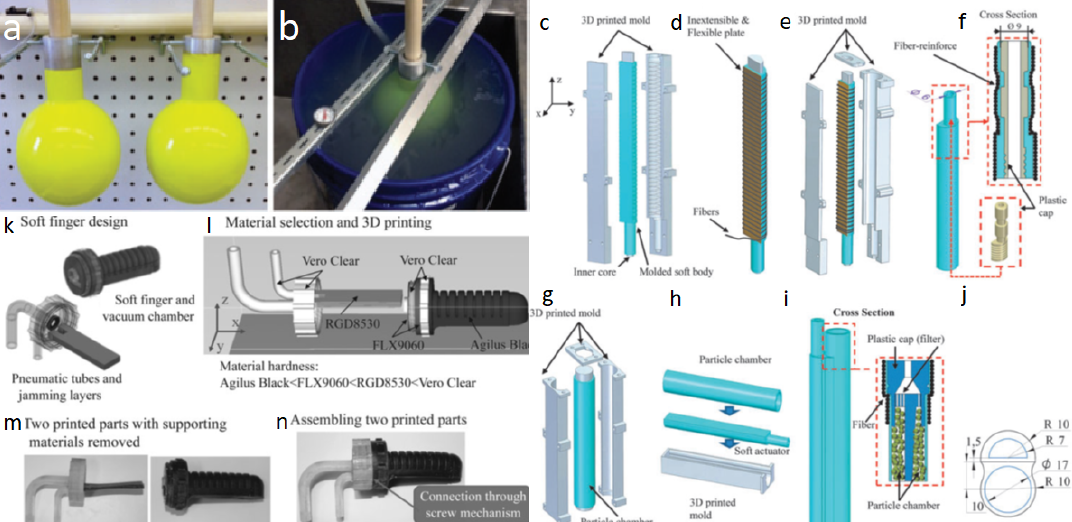
Figure 3. A selection of soft jamming robot fabrication methods. Clockwise from top-left; ( a , b ) show the dip moulding process of commercialized ellipsoidal bag grippers composed of a custom polychloroprene formula, whereby mandrels are dipped into the formula and left to dry ( a ) and subsequently warmed in a hot water bath to allow the removal of the membrane ( b ) [14]. ( c – j ) display the application of 3D-printed cast moulds in the complex, multi-step manufacturing process of a silicone rubber soft jamming